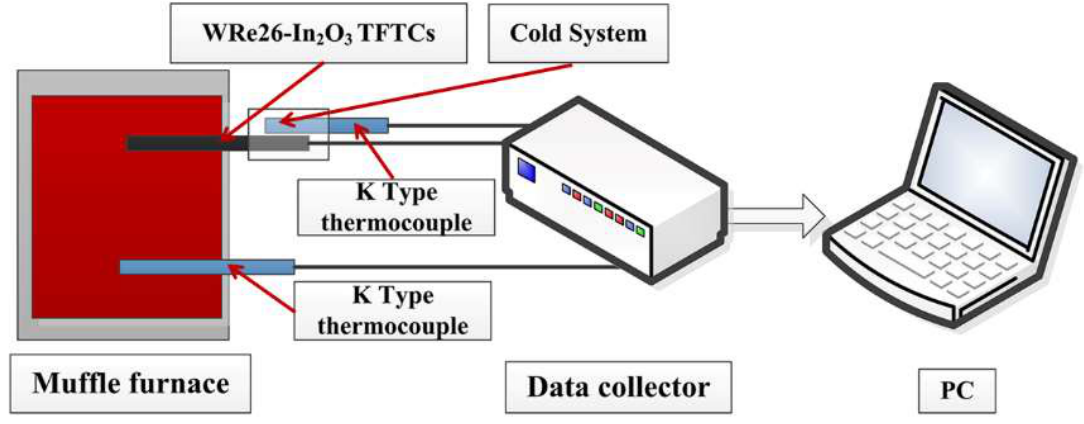
Figure 6. Thermoelectric test system of WRe26-In 2 O 3 TFTCs.